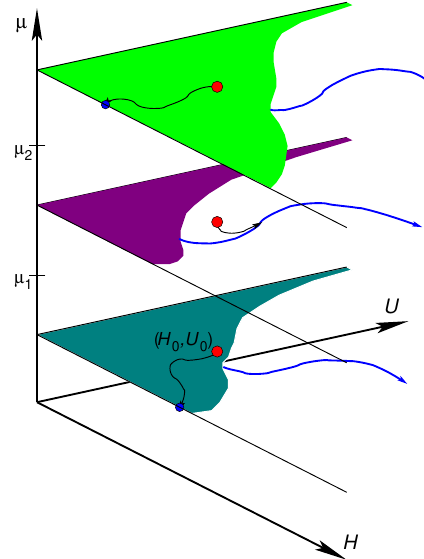
Figure 5. Strongly simplified representation of a hypothetical structure of the ( H , U ) phase space of the “enhanced simplified” Grigorian–Ostroumov model. Three copies of the phase-space plane, representing different values of the friction coefficient µ , are shown; the parameters k , τ ∗ and p ∗ are held fixed. The red dots mark an (arbitrarily chosen) initial condition ( H 0 , U 0 ) . The avalanche evolves either to a final rest state indicated by the blue points on the axis U = 0 (if µ < µ 1 or µ > µ 2 ) or towards and along a critical line (in blue) that approaches either a fixed point corresponding to a moving steady state or to a state where the avalanche grows and/or accelerates indefinitely. The colored areas indicate the basin of attraction of the fixed points on the axis U =